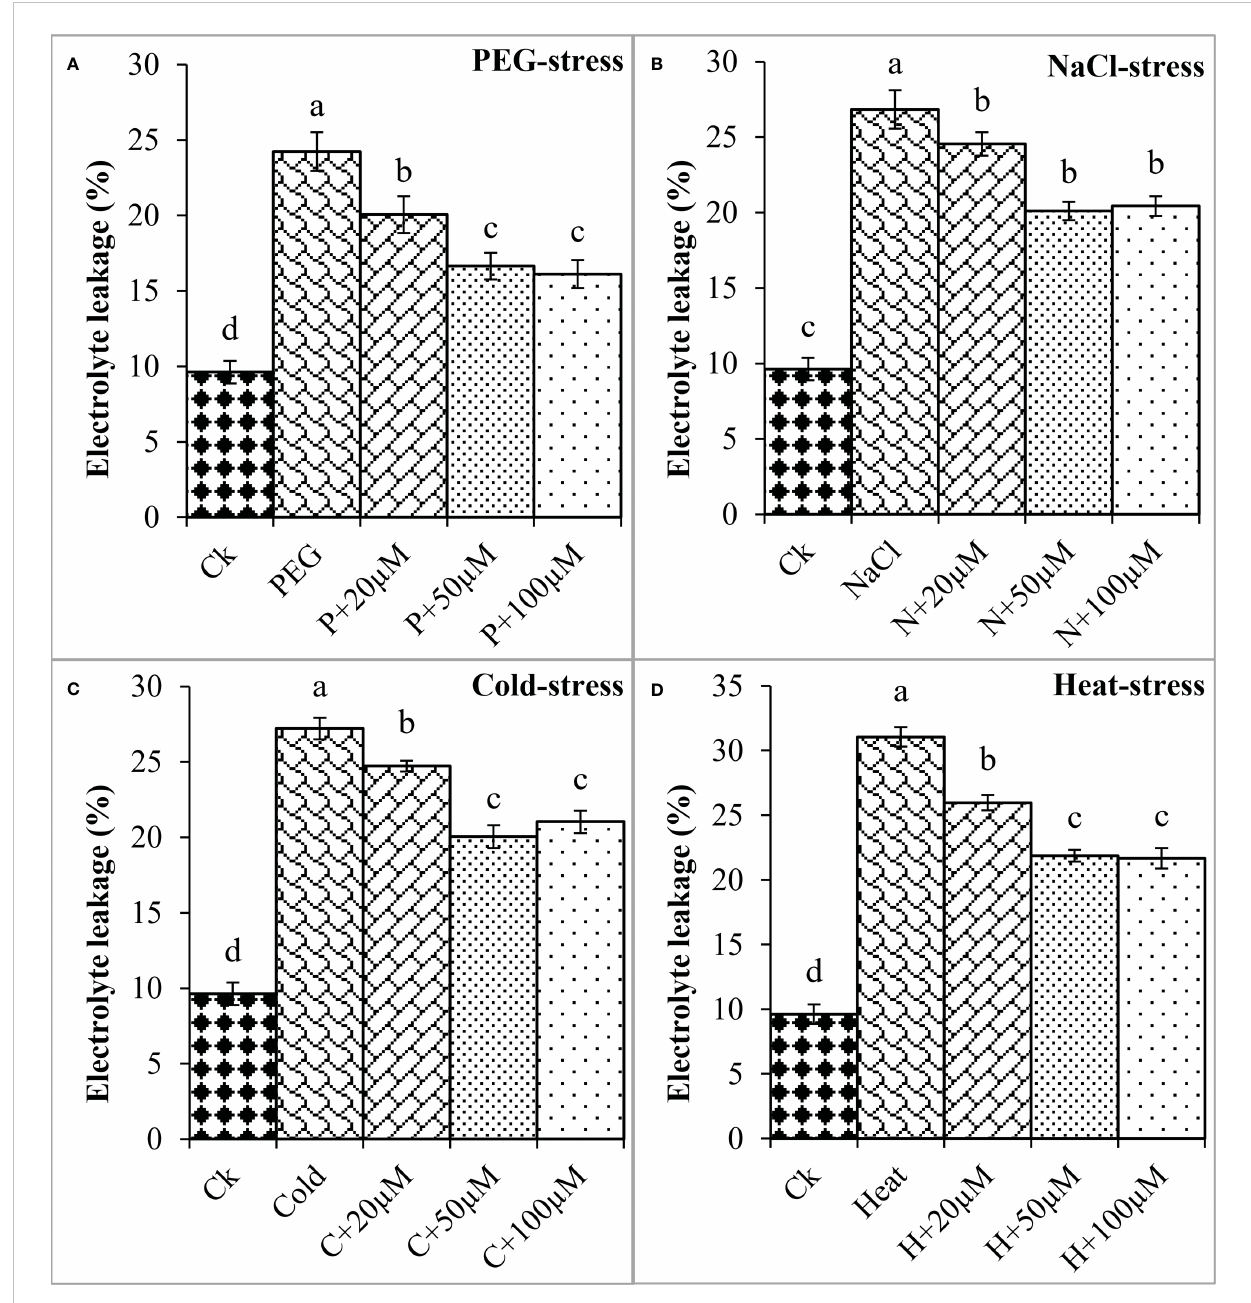
FIGURE 3 Effect of different concentrations of melatonin on the activity of Electrolyte leakage (EL) under PEG (A) , NaCl (B) , Cold (C) , and Heat (D) . Values are the means ± SD (n=3). Different letters on the bars show a statistical signi fi cance level at p<0.05 . Here, µM is indicating (µmole L -1